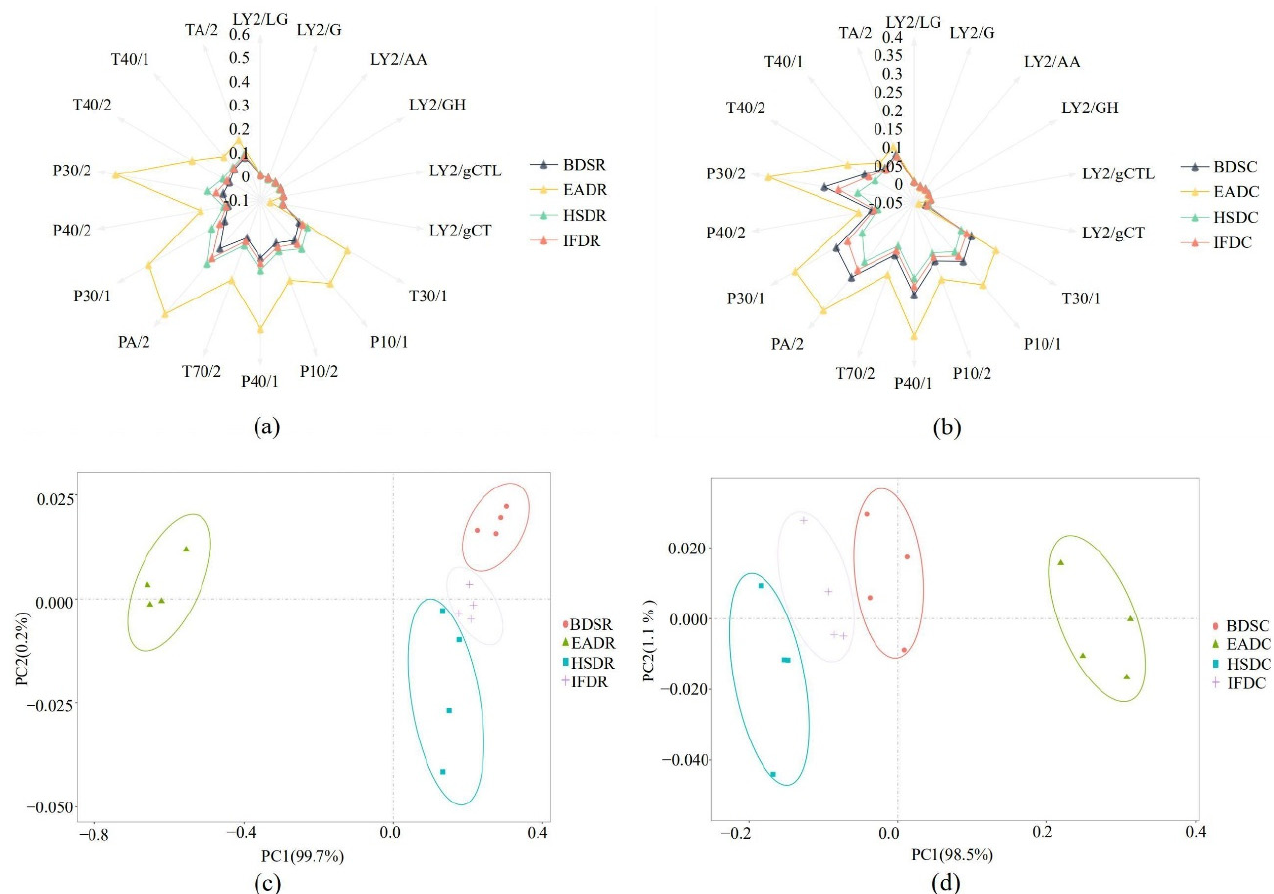
Figure 1. Radar plots ( a , b ) and principal component analysis (PCA) plots ( c , d ) of raw (R) and cooked (C) sea bass subjected to different slaughter methods. IFD, ice faint to death; HSD, head shot control stun death; EAD, eugenol anesthesia to death; BDS, bloodletting to death.